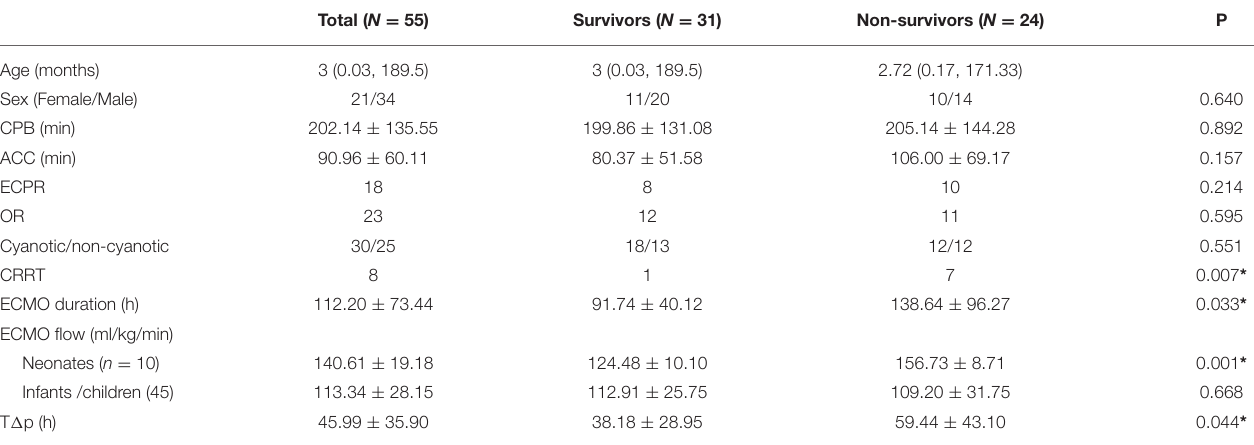
TABLE 2 | Comparison of the clinical characteristics between survivors and